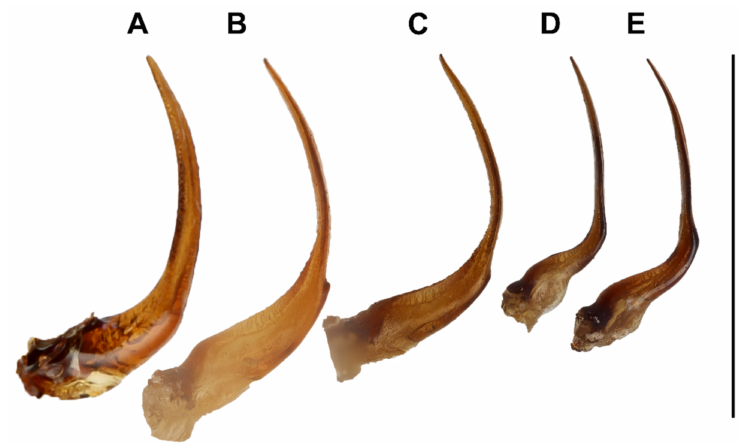
Figure 4. Penis in lateral view of Laccophilus alluaudi species group members from Comoro Islands: ( A ) L. tigrinus (HT 13263); ( B ) L. denticulatus ; ( C ) L. mohelicus ; ( D ) L. mayottei ; ( E ) L. michaelbalkei . Scale bar 1 mm. Note that ( A ) (Photo: MNHN/Christophe Rivier) is photographed under different circumstances (equipment, angle and resolution) and is partly covered with residual glue hiding a subbasal shelf similar to in ( C